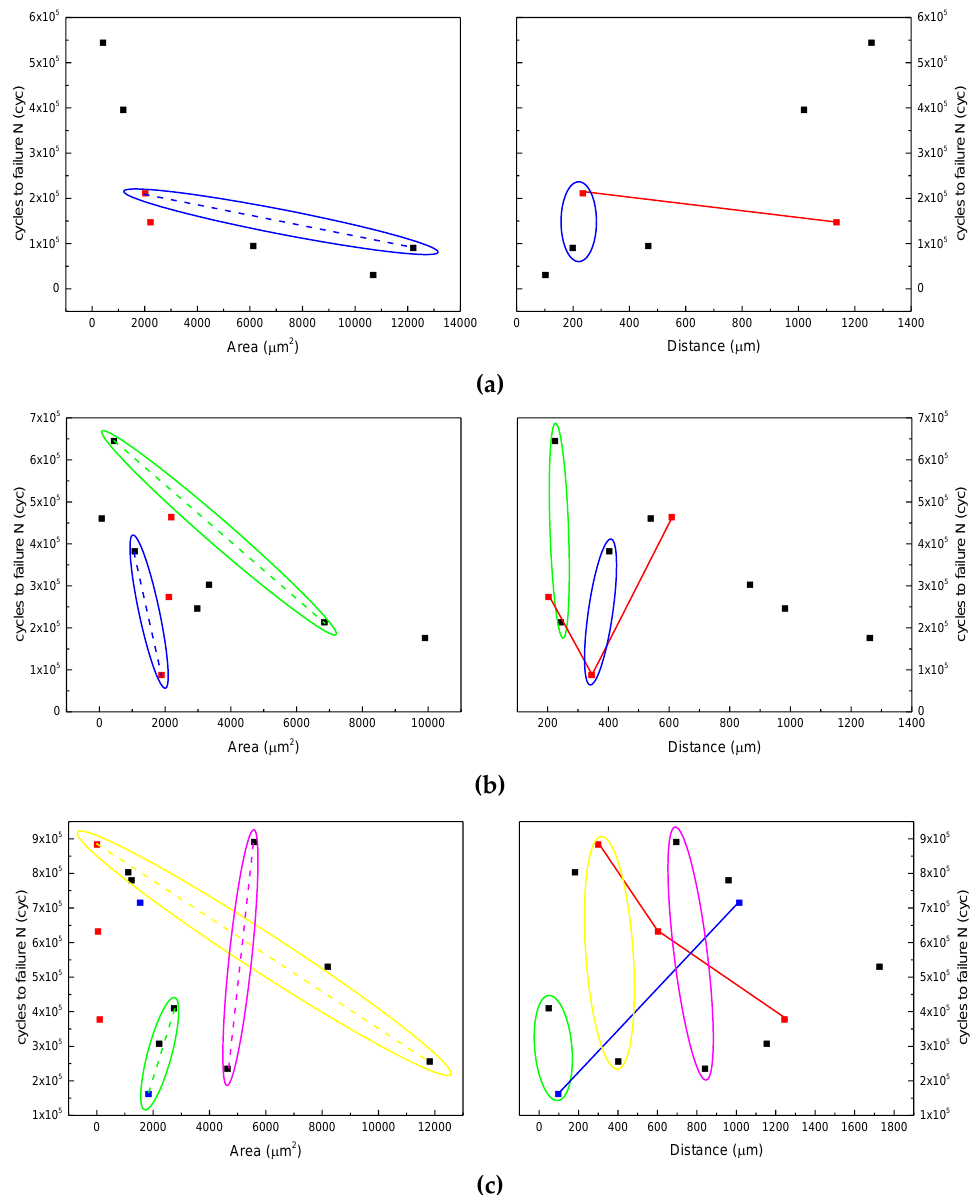
Figure 11. Influence of the size and location of a pore on the fatigue life under ( a ) 800, ( b ) 760, and ( c ) 720 MPa.